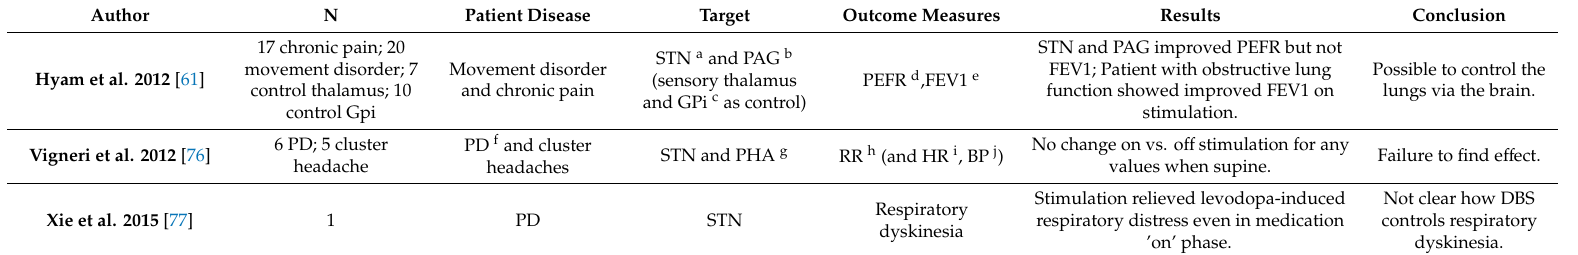
Table 3. Key Studies surrounding DBS and